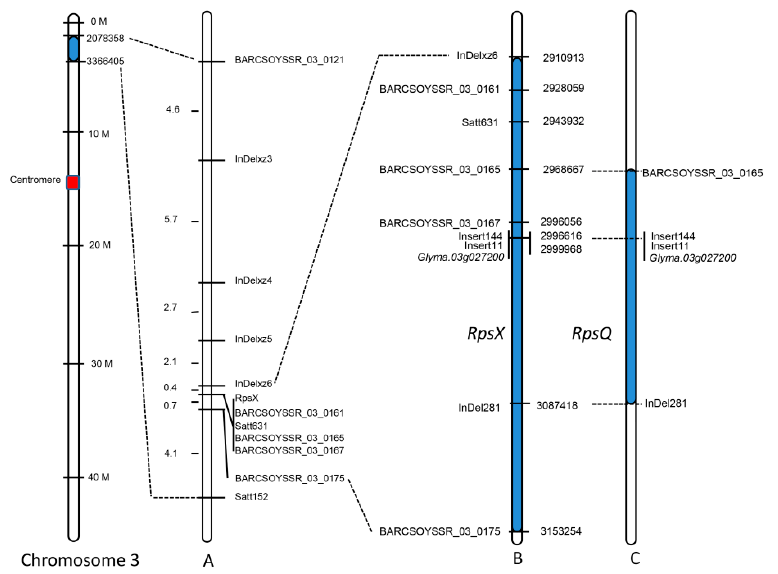
Figure 2. Genetic and physical maps of the RpsX region. ( A ) Genetic linkage analysis of RpsX based on the F 2:3 mapping population. The genetic distances (cM) are provided on the left, and marker locations are indicated on the right. ( B ) Candidate physical interval of RpsX (blue region) and the physical positions of the linked and co-segregated markers of RpsX . ( C ) RpsQ mapping interval and the corresponding markers [20].